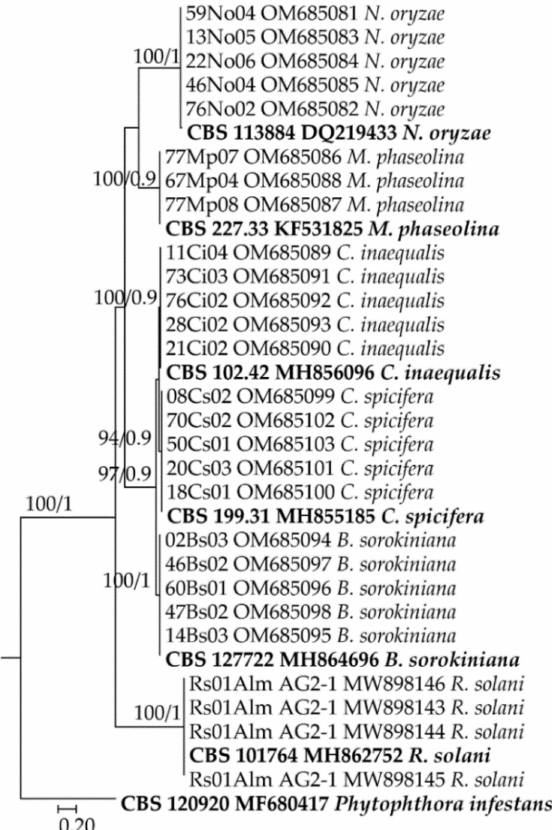
Figure 3. Phylogenetic tree based on maximum likelihood using IQ-TREE and Bayesian inference (BI) using MrBayes with ITS sequences of fungal isolates (except Fusarium ). At each node are the bootstrap values (left) and posterior probabilities (right). Sequences used as references and outgroups in the present study are presented in